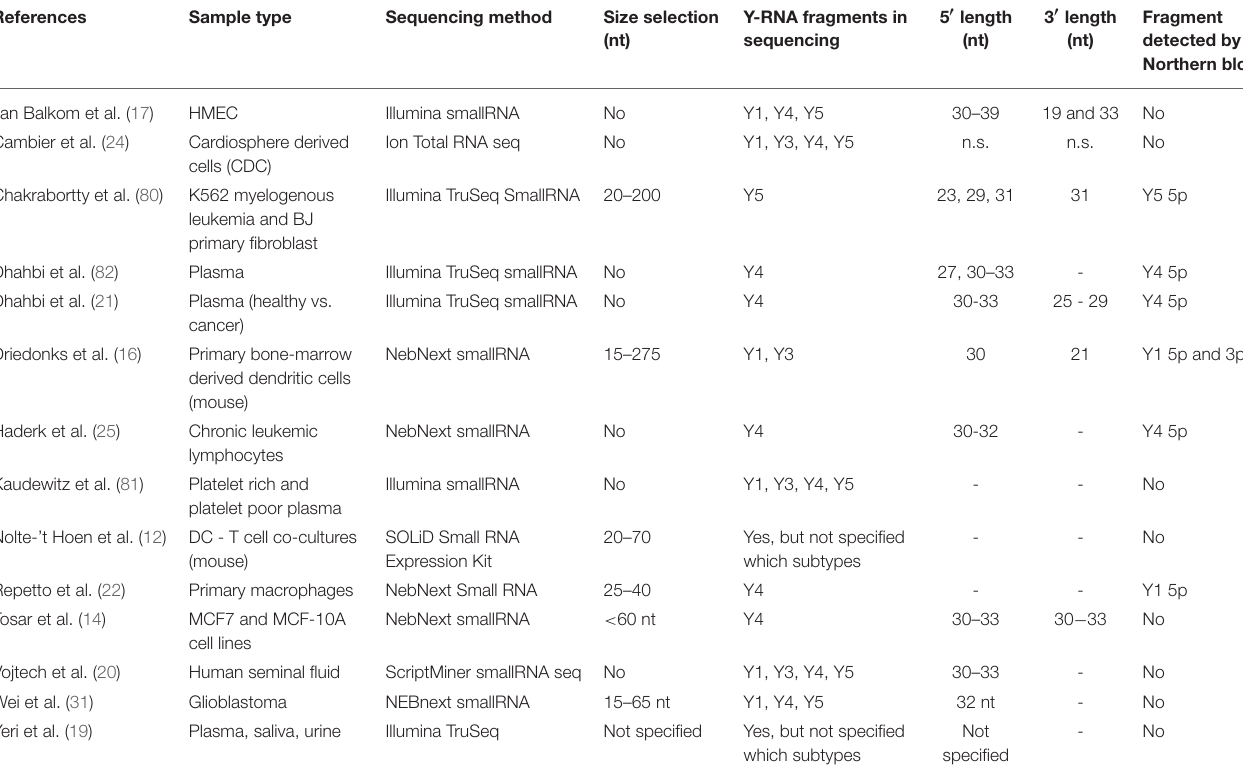
TABLE 2 | Overview of studies reporting the presence of Y-RNA fragments by RNA sequencing analysis of extracellular